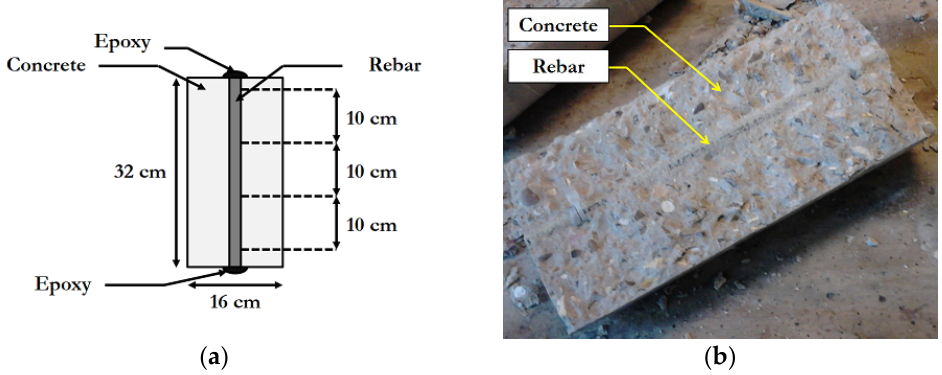
Figure 2. ILSS test specimens for indirect immersion: ( a ) geometry of specimens and ( b ) picture of a specimen after the splitting of surrounding concrete.